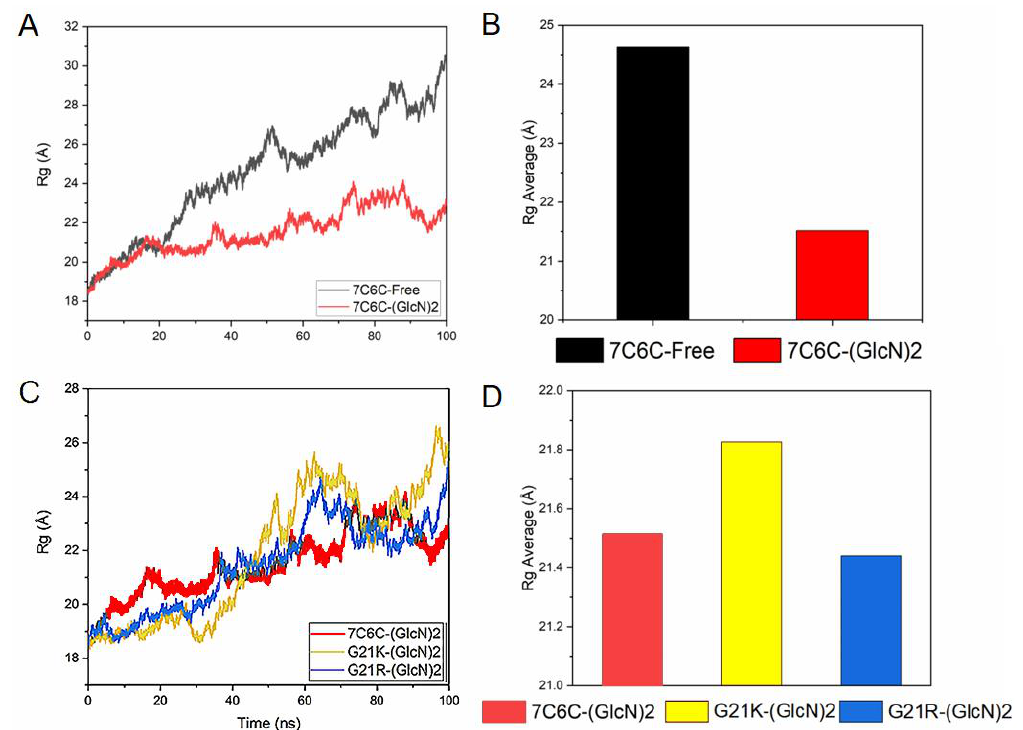
Figure 3. ( A ) Rg plot of 7C6C-free and 7C6C-(GlcN) 2 complex; ( B ) average of Rg plots of 7C6C-free and 7C6C-(GlcN) 2 complexes during MD simulations; ( C ) Rg plot of 7C6C-(GlcN) 2 , G21K-(GlcN) and G21R-(GlcN) 2 ; ( D ) average of Rg plots of 7C6C-(GlcN) 2 , G21K-(GlcN) and G21R-(GlcN) 2